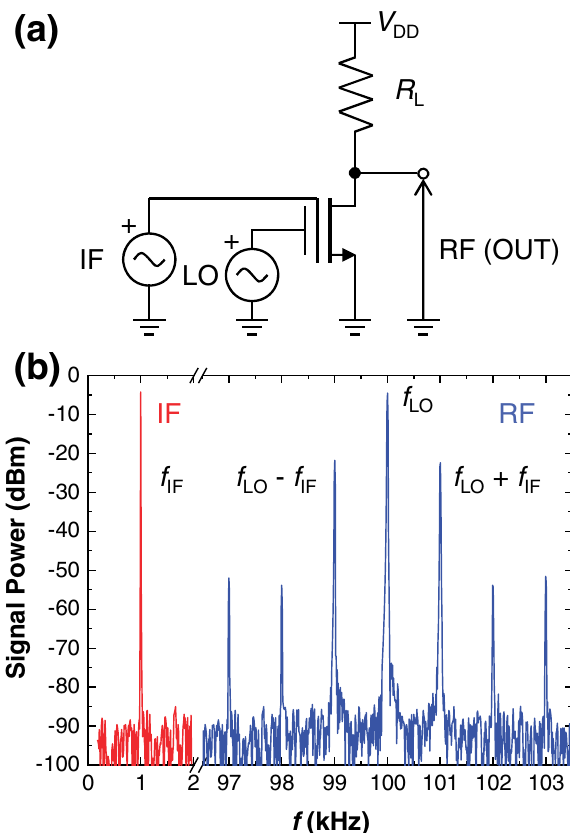
Fig. 6 An upconverting frequency mixer based on a dual-gate GESFET. a A schematic of the mixer. The output RF signal was obtained by mixing the input IF and LO signals. b The power spectrum of the input IF and output RF signals. The input IF signal is represented with a sine wave at a frequency f IF = 1 kHz, while the LO frequency is f LO = 100 kHz. The output RF signal comprises a signal at f LO , lower sideband at f RF = f LO − f IF = 99 kHz, higher sideband at f RF = f LO + f IF = 101 kHz, and other harmonics of much smaller power. The conversion loss of 17.5 dB represents a power difference between the IF and RF sideband signals. The corresponding waveforms are shown in Supplementary Fig.